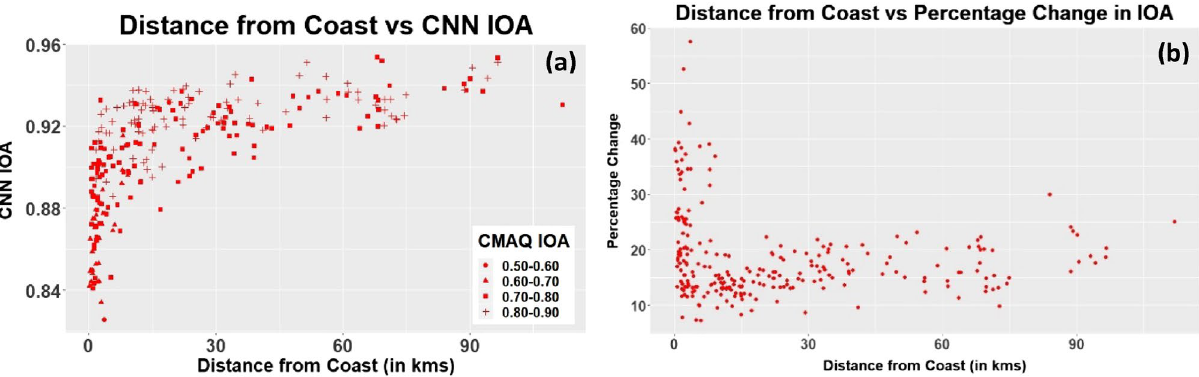
Figure 3. ( a )Variation of IOA based on distance from the coast. The x-axis represents the distance of the station from the coast, and the y-axis represents the index of agreement. The colored symbols represent the range of CMAQ-IOA for the corresponding station. All IOA are based on one-day ahead prediction only. ( b ) Percentage change in IOA based on distance from the coast. The figure shows the percentage increase in IOA of the CNN model-method 2 when compared with the IOA of the CMAQ were created using R ggplot2 package: https:// ggplo t2. tidyv erse. org/). If a district had more than one station, we averaged its IOAs. We found that inland cities performed slightly better than the coastal ones, and their